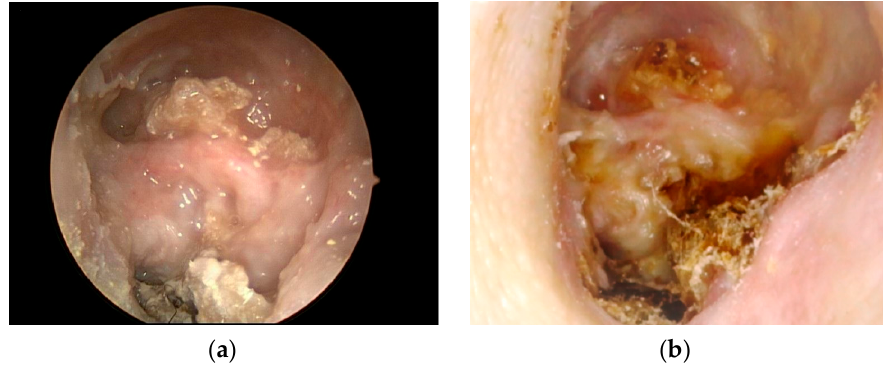
Figure 1. Left ear canal and mastoid cavity at initial presentation ( a ) and after six months, ( b ) with persistent, widely exposed necrotic bone on the floor of the external auditory meatus, facial ridge, and debris.